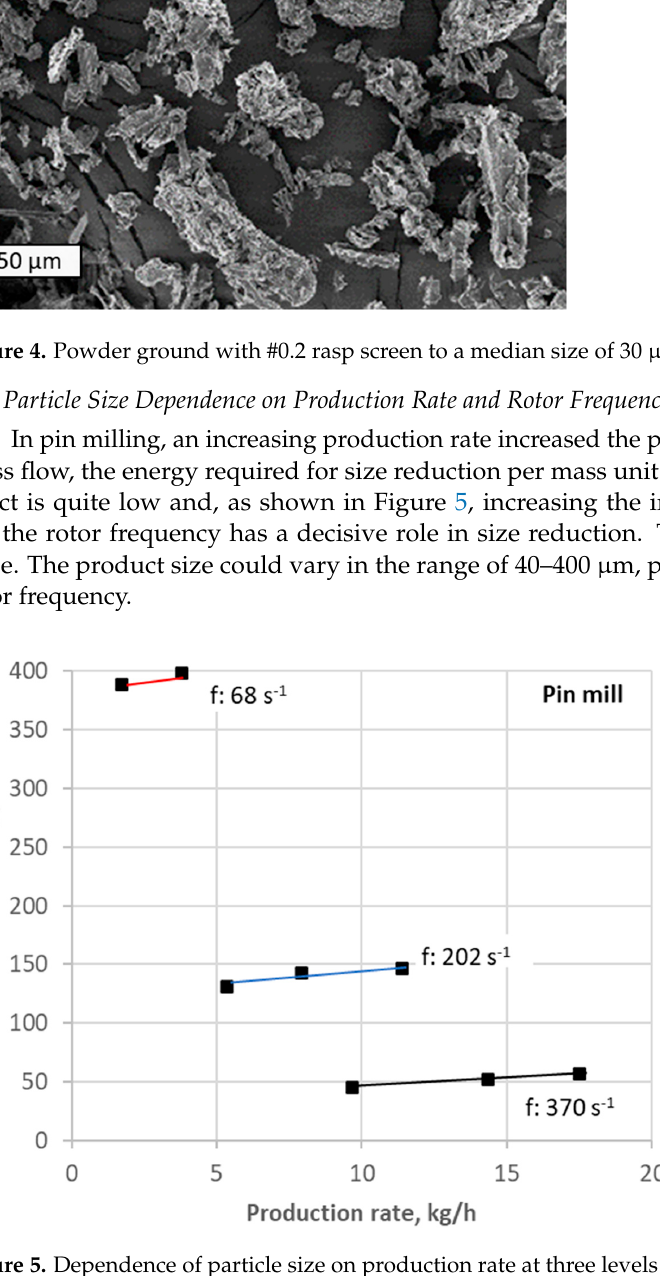
Figure 3. Powder ground with Ø0.5 smooth screen to a median size of 130 μ m. Magnitude 500×.